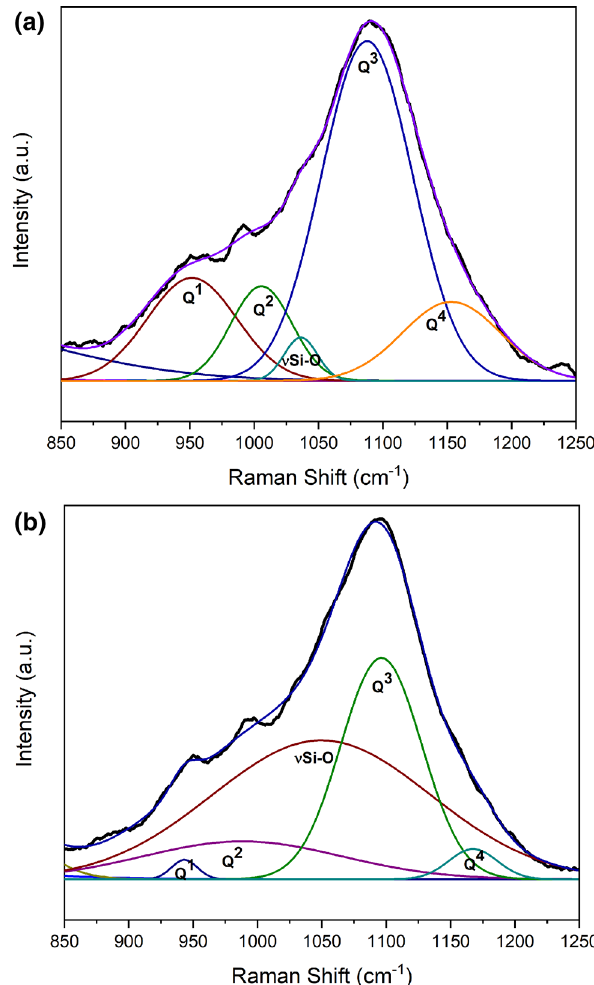
Figure 7. Gaussian deconvolution of the HF Raman band (850 cm −1 to 1250 cm −1 ) indicating the overlapping peaks corresponding to Q n species present in the scratched network of (a) untreated and (b) heat-treated surfaces (R-square > 0.99 in both spectral fits).